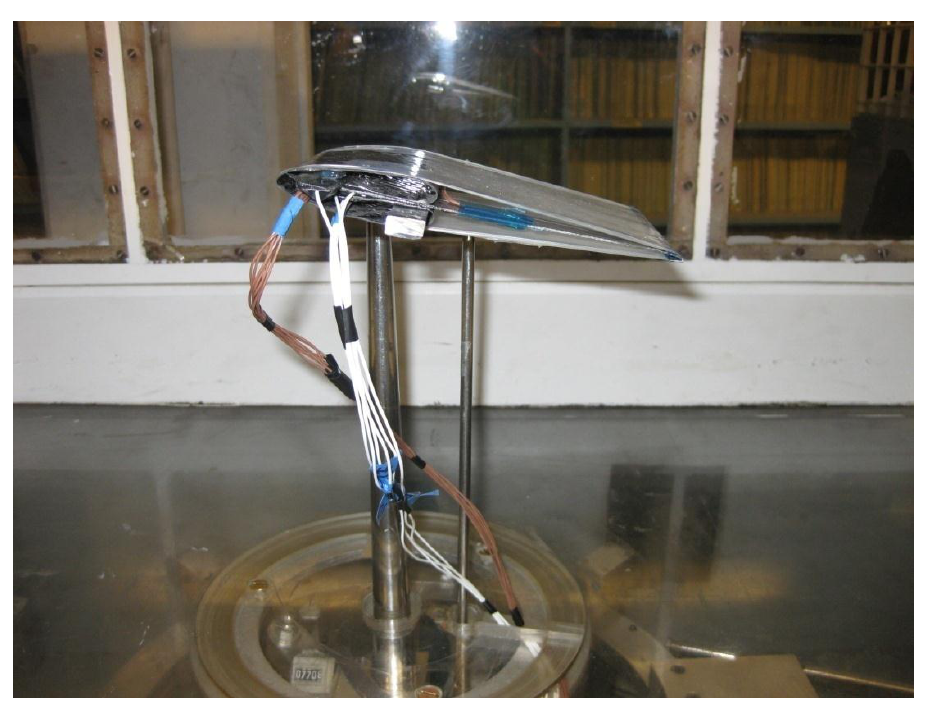
Figure 9. Side view of airfoil in wind